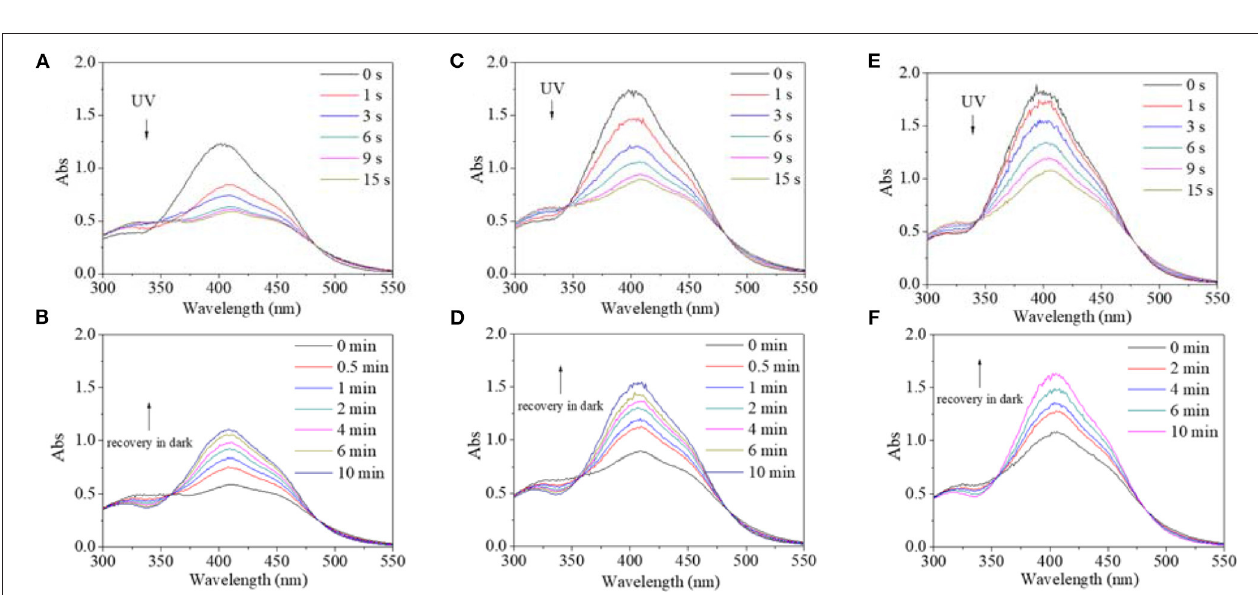
FIGURE 7 | UV spectra of PBLG2 DMF solution as a function of irradiation time (A) and recovery time (B) . (C) Absorbance at 400nm of PBLG2 DMF solution as a function of cycle number. (D) Irradiation response time and recovery response time as a function of cycle number. Irradiation was performed under blue light, and the recovery process was performed under darkness and room temperature. Polymer concentration was 0.8 mg/mL.